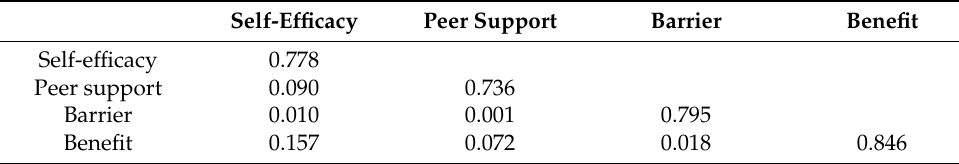
Table 7. Discriminant validity analysis of PrEP adherence questionnaire.